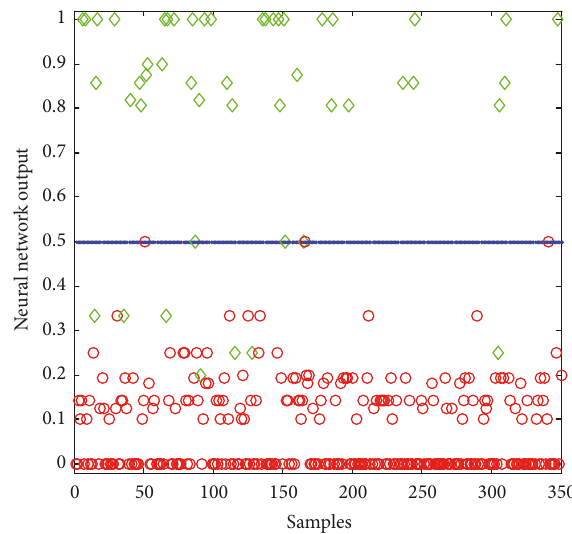
Figure 3: The RBF NN model training result (accuracy: 97.4%).